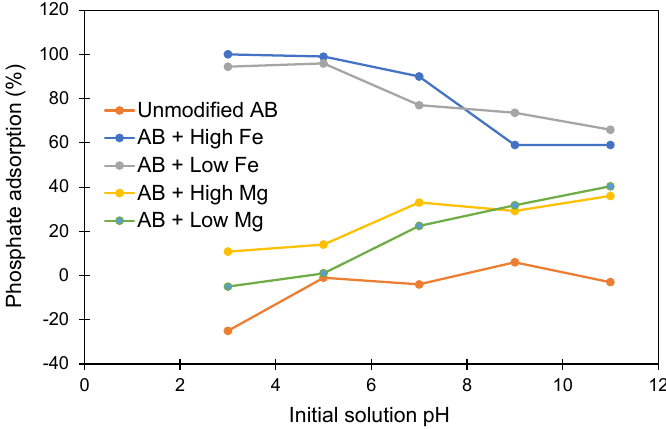
Figure 5. Phosphate adsorption affected by initial solution pH (3–11).